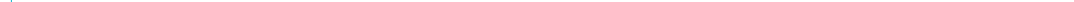
Figure 1: Insulin action in liver and fat tissue. The insulin receptor is a tyrosine kinase that undergoes autophosphorylation and catalyses the phosphorylation of cellular proteins such as Shc and Cbl, members of the IRS family. Upon tyrosine phosphorylation, these proteins inter- act with signalling molecules through their SH2 domains, resulting in a diverse series of signalling pathways, including activation of PI(3)K and downstream PtdIns(3,4,5)P3-dependent protein kinases, Ras and the MAP kinase cascade, and Cbl/CAP and the activation of TC10. These pathways act in a concerted fashion to coordinate the regulation of vesicle trafficking, protein synthesis, enzyme activation and inactivation, and gene expression, resulting in the regulation of glucose, lipid and protein metabolism [19]. The illustration on the left side of the figure shows the insulin-induced activation of the insulin receptor in hepatocytes. Here, it stimulates glycolysis and therefore the formation of gly- colytic intermediates such as dihydroxyacetone phosphate (DHAP) and glyceraldehyde-3 phosphate (G3P), which can be used for triglyceride synthesis. It also suppresses gluconeogenesis and at the same time stimulates cholesterol synthesis and the formation of fatty acids, which can also be used for the synthesis of triglycerides. The illustration on the right side of the figure shows the insulin-induced activation of the in- sulin receptor in adipocytes. Here, it stimulates glycolysis and the formation of glycolytic intermediates such as DHAP and G3P. However, adipocytes lack glycerol kinase and therefore use DHAP (as they cannot use G3P) as a precursor for triglyceride synthesis. Furthermore, it stimulates fatty acid uptake, hence stimulating the synthesis of triglycerides. Drawings by Vincenzo Antonio Vianna